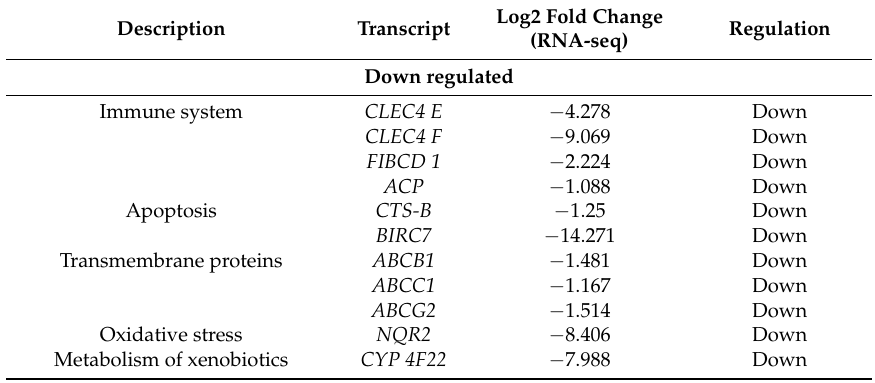
Figure 6. Pathway classification of differentially expressed genes. The x -axis shows the number of differentially expressed genes. The y-axis shows the pathway name. Table 4. Detoxification and immune-related differentially expressed genes in gills of bay scallop exposed to 80 mg/L PA up to 48 h.